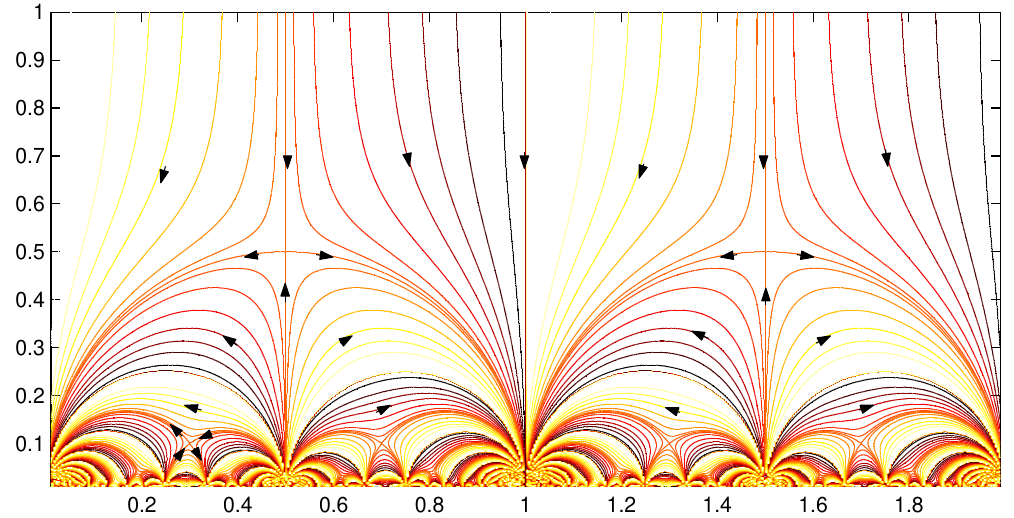
Figure 6 . Temperature flow of the conductivity on the event horizon for Γ 0 (2) symmetry, assuming it is generated by varying | f | , keeping arg( f ) fixed. The diagram is obtained simply by plotting lines of constant arg( f ) as in